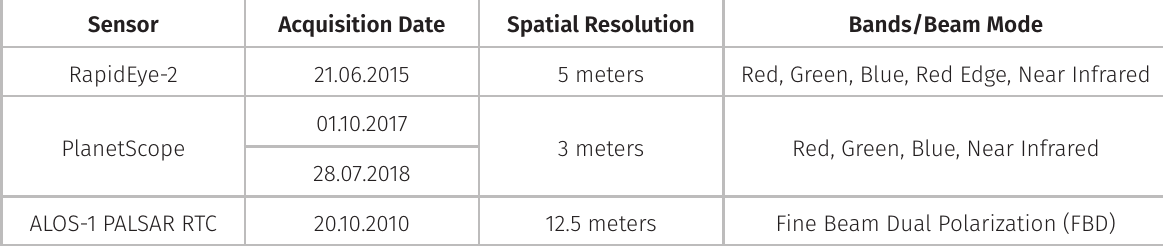
Table I. In addition to multispectral imagery, the ALOS PALSAR DEM with 12.5 m resolution (ASF